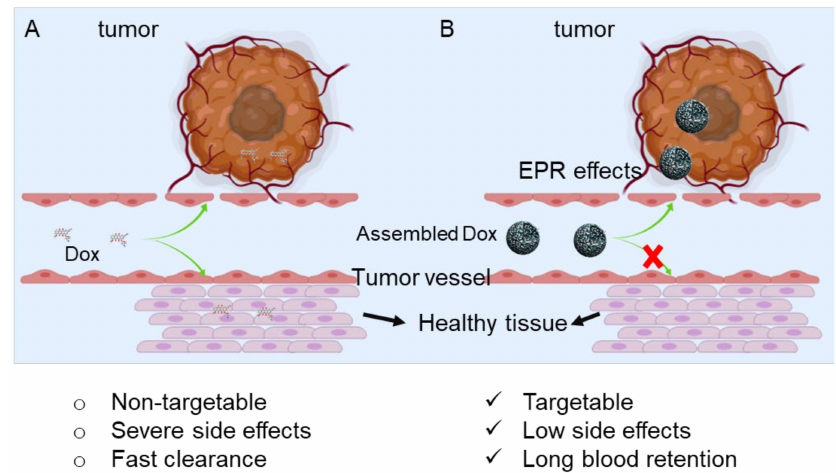
Figure 1. Schematic presentation of the delivery of Doxorubicin to tumor lesions via assembled nanoparticles ( B ) compared with non-specific administration of Dox ( A ). When the Dox is assembled into nanoparticles, the tumor targetability of the Dox can be increased by leveraging the EPR e ff ects. Simultaneously, the side e ff ects will be decreased. Also, the nanoformulation Dox will show a longer blood circulation time than